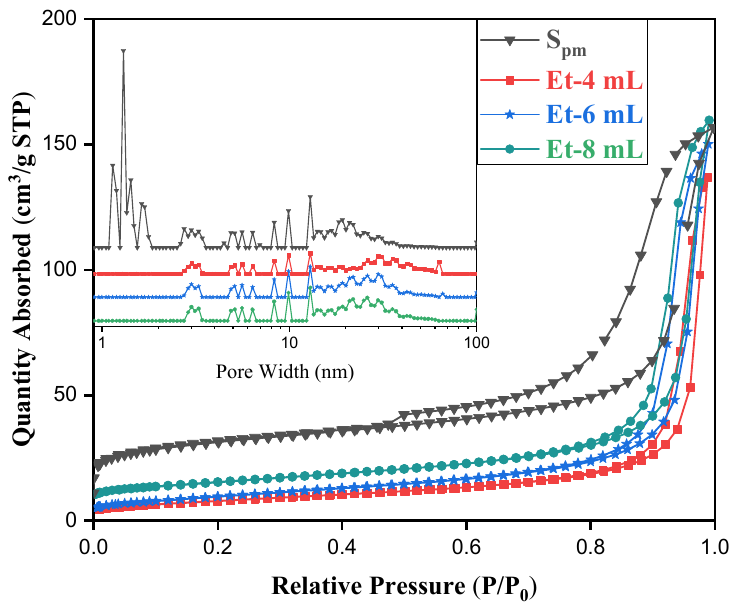
Figure 3. Nitrogen adsorption–desorption isotherms and pore size distributions (inset) of selected samples: S pm , Et-4 mL, Et-6 mL and Et-8 mL.